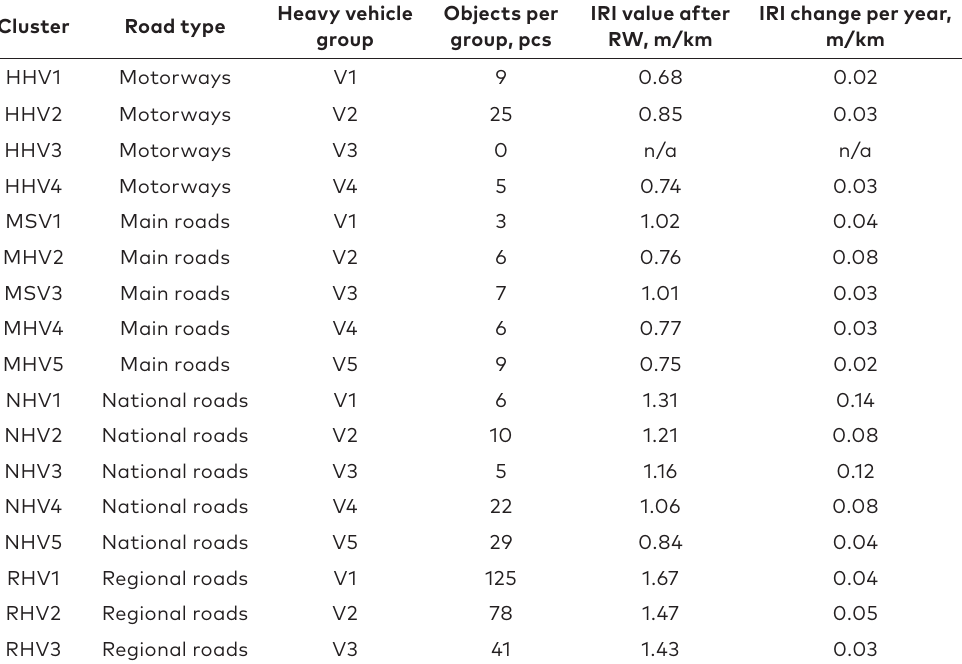
Table 7. IRI values after road work by separate heavy loaded vehicle